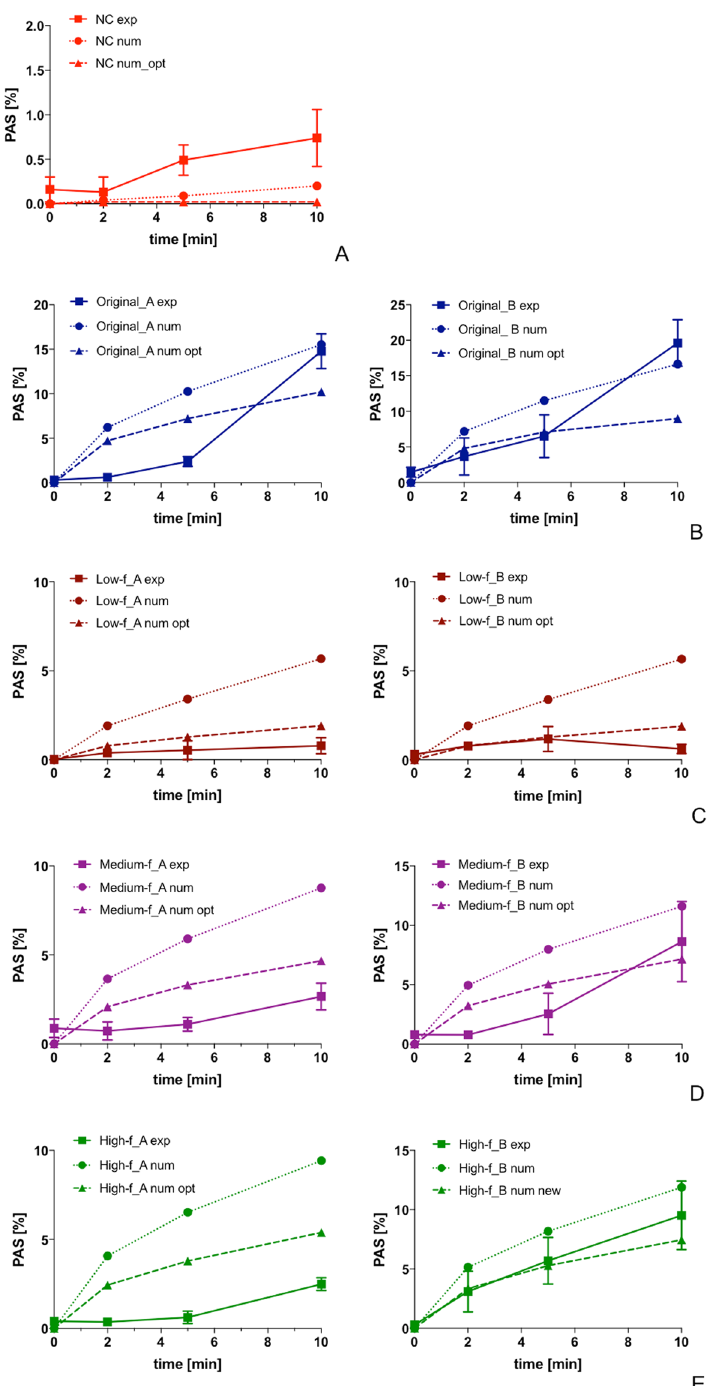
Figure 5. Comparison of numerical predictions of the dynamics of PA over time and experimental in vitro values: ( A ) NC curve; ( B ) Original curves; ( C ) low-frequency curves; ( D ) medium- frequency curves; ( E ) high- frequency